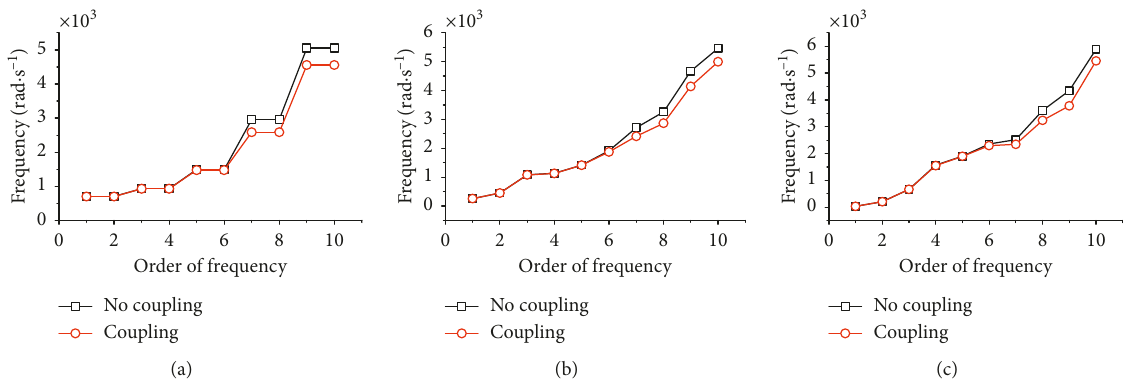
Figure 7: The effect of disk-shaft coupling term on rotor natural frequency: (a)